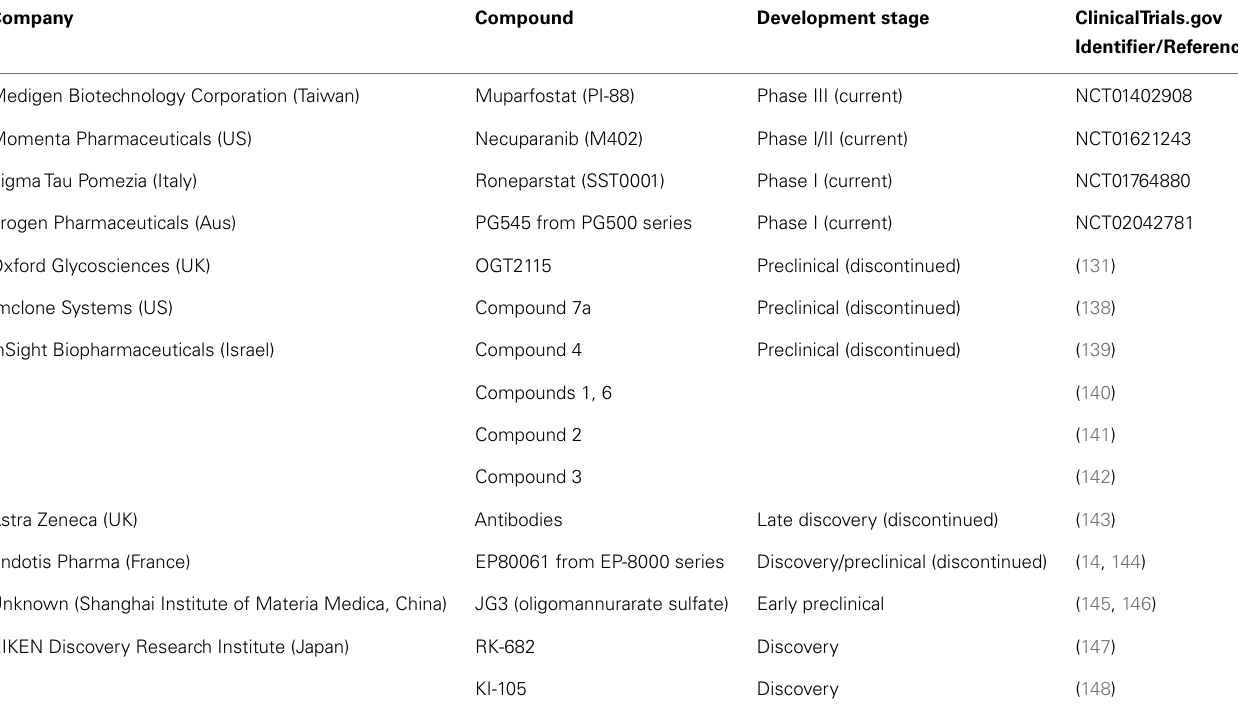
Table 2 | Past and present drug discovery/development programs targeting heparanase in oncology